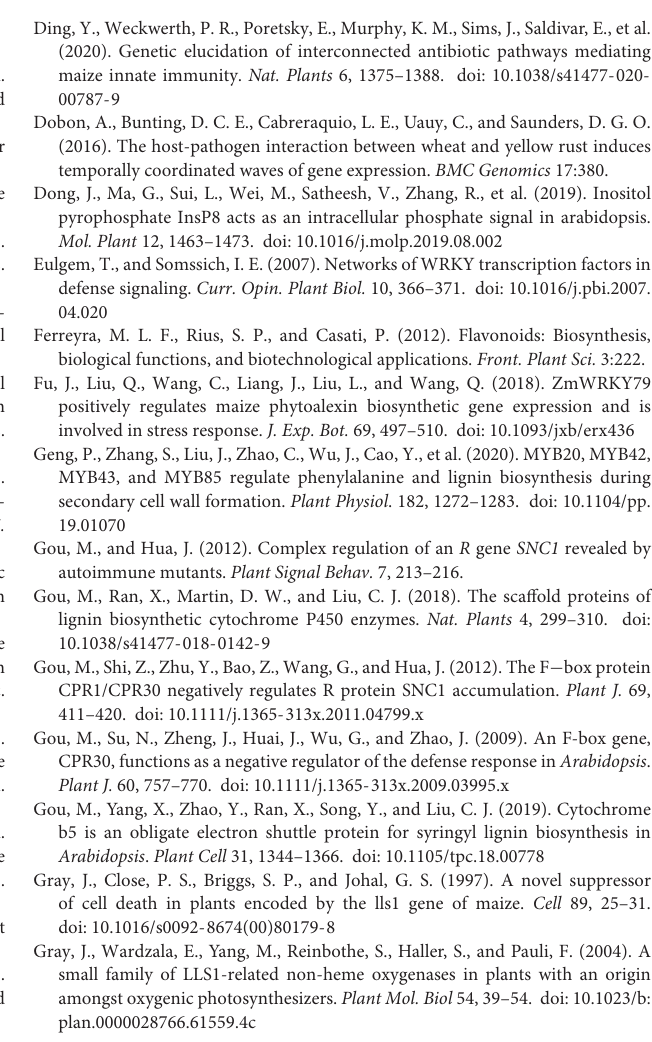
Supplementary Table 12 | Common differentially accumulated metabolites in the comparisons of mutant vs. WT in Les4 , Les10 , and Les17 . Supplementary Table 13 | Fold change of gene expressions involved in phenylpropanoid and lignin synthesis. Supplementary Table 14 | Fold change of accumulated metabolites involved in phenylpropanoid and lignin synthesis. Supplementary Table 15 | Fold change of gene expressions involved in flavonoid biosynthetic genes. Supplementary Table 16 | Fold change of accumulated metabolites involved in flavonoid synthesis. Supplementary Table 17 | Fold change of expressions level for zealexins and kauralexins biosynthetic genes in Les mutants compared to their respective wild